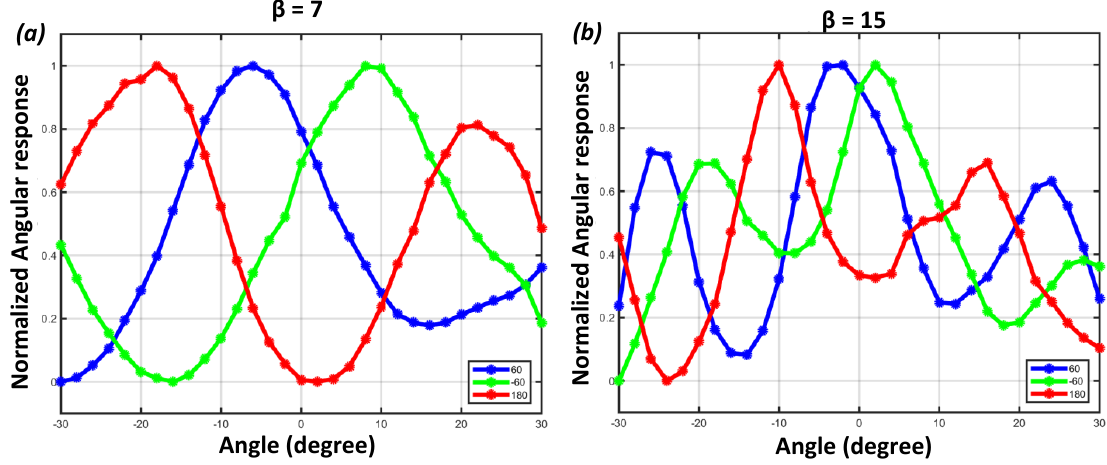
Figure 11. Measured A-SPAD responses to change in incident angle. ( a ) β = 8; ( b ) β =